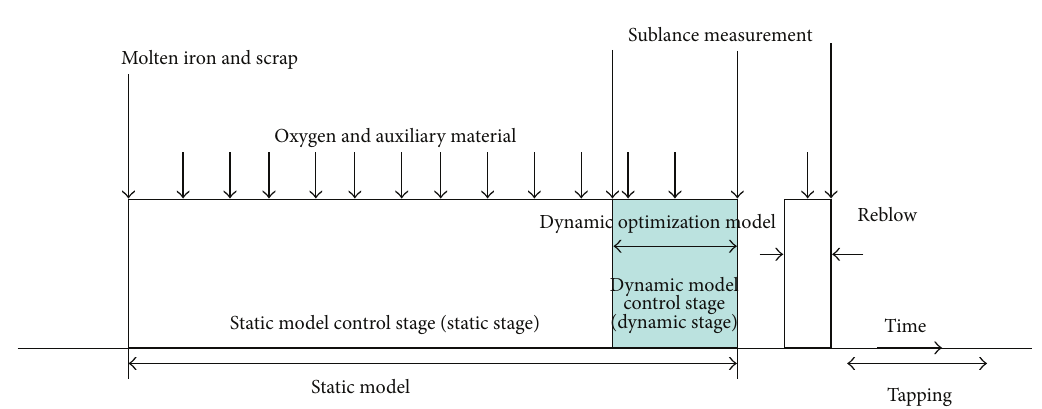
Figure 1: General view of a converter.